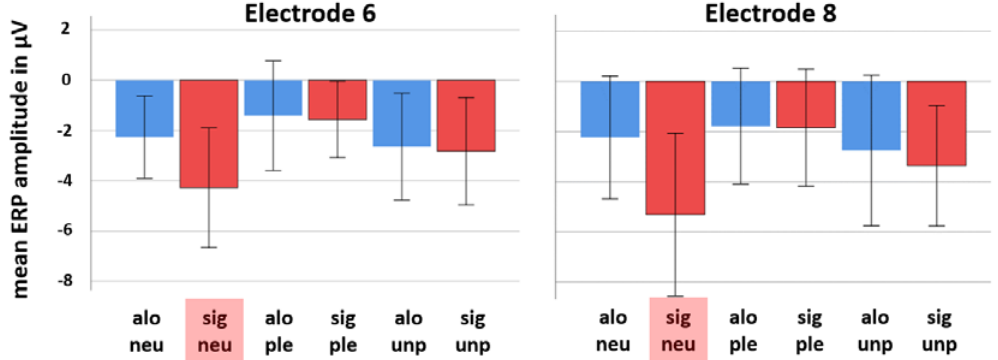
Figure 2. Bar diagrams (including standard deviations) showing mean ERP amplitudes at 708 ms post-stimulus of all emotion categories and both social conditions (alone (alo) and significant other (sig)) for electrode 6 and 8. Note that the condition “significant other neutral emotion category” (sig neu, marked in red color) constantly elicited the most negative going brain potential at both electrode locations with a larger effect at electrode 8 (around FPz). Significant other pleasant = sig ple, significant unpleasant = sig unp, alone neutral = alo neu, alone pleasant = alo ple, alone unpleasant = alo unp.